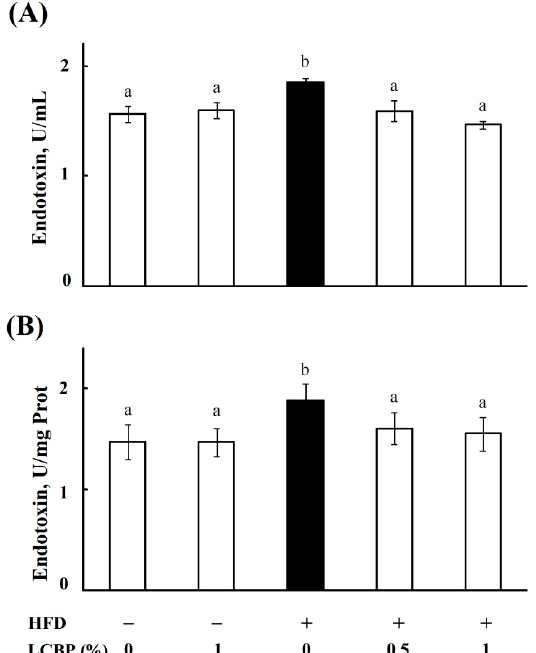
Figure 2. The effect of LCBP on endotoxin levels in serum and liver. The level of endotoxin in mouse serum ( A ) and liver ( B ) was measured by using a Pierce LAL Chromogenic Endotoxin Quantitation Kit (Thermo Fisher Scientific Inc., Rockford, IL, USA). The data represents the mean ± SD of four mice. Bars with different letters differ significantly ( p < 0.05). HFD, high fat diet; LCBP, Lonicera caerulea L. berry polyphenols.